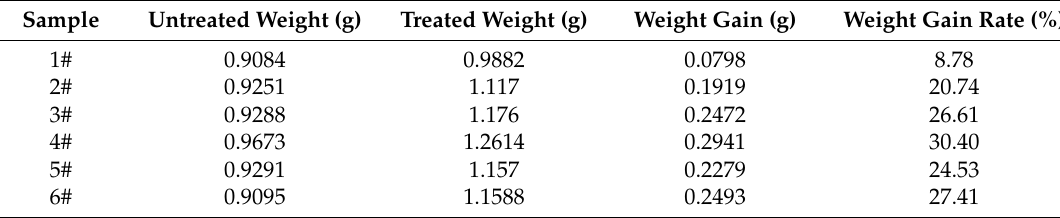
Table 2. Weight change before and after Ag coated